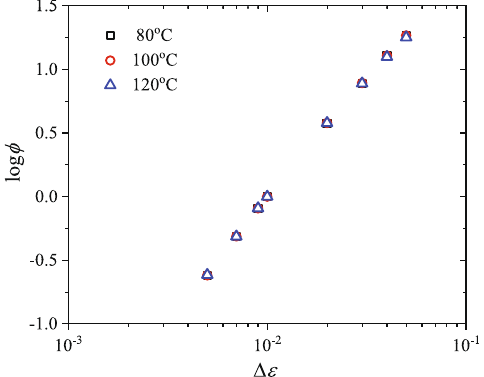
Fig. 8 Vertical shift factors versus dynamic strain amplitude. The vertical shift factors are proportional to the dynamic strain amplitudes, and for the same strain amplitude, the vertical shift factors for different aging temperatures are